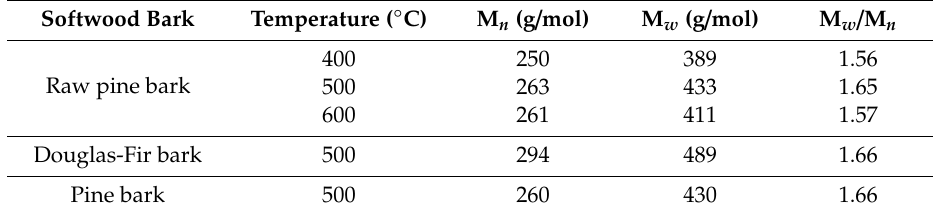
Table 4. M n , M w , and M w / M n distribution of pyrolysis oil produced from raw pine bark, pine, and Douglas-Fir bark.